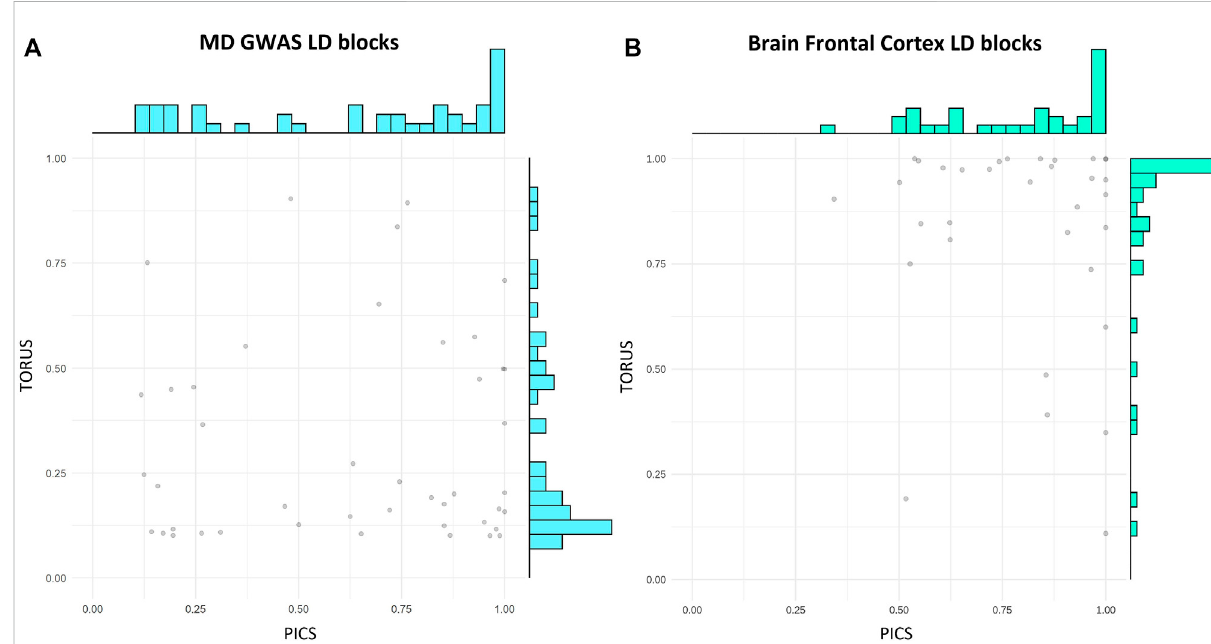
FIGURE 3 PICS and TORUS fi ne-mapping probabilities have different distributions. Scatter plot and distribution of PICS and TORUS probabilities for LD blockscontainingGVswithPICSandTORUSprobabilities > 10%. (A) MDGWASand (B) BrainFrontalCortexLDblock.PICS,Probabilistic Identi fi cation of Causal SNPs; LD, linkage disequilibrium; GVs, genetic variants; MD, major depression; GWAS, genome-wide association